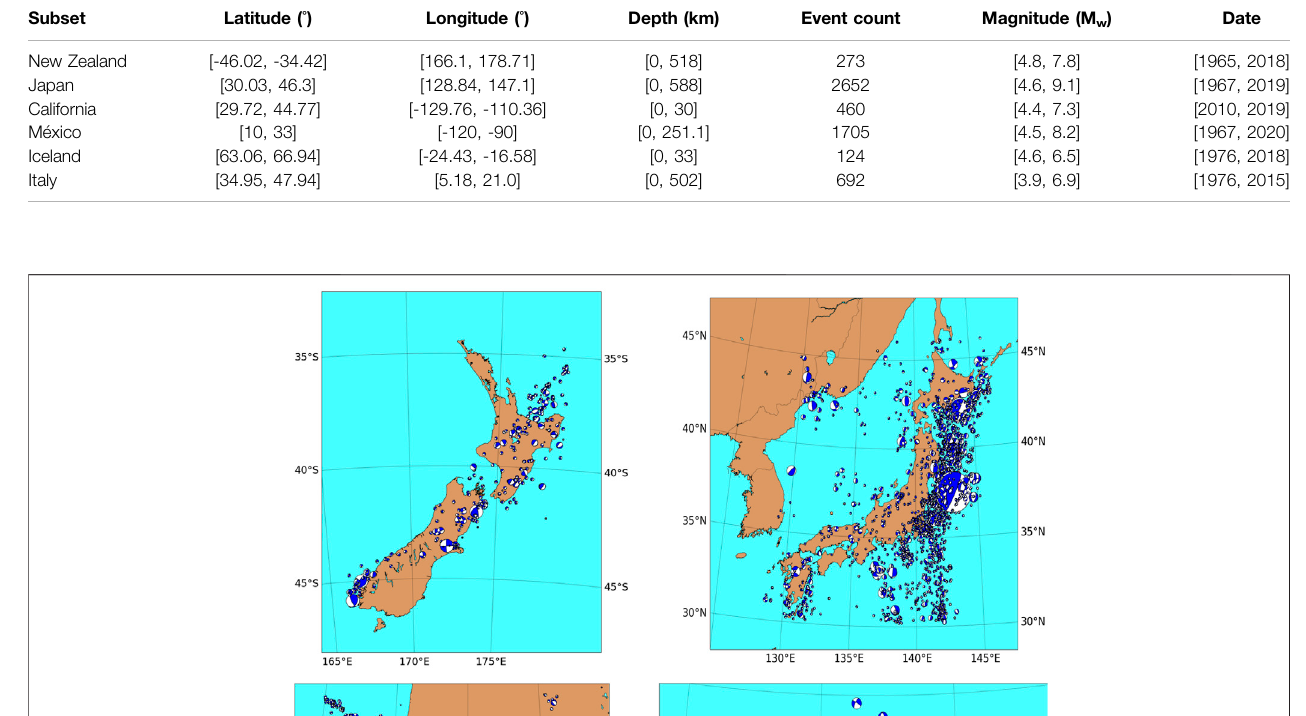
Frontiers in Earth Science |